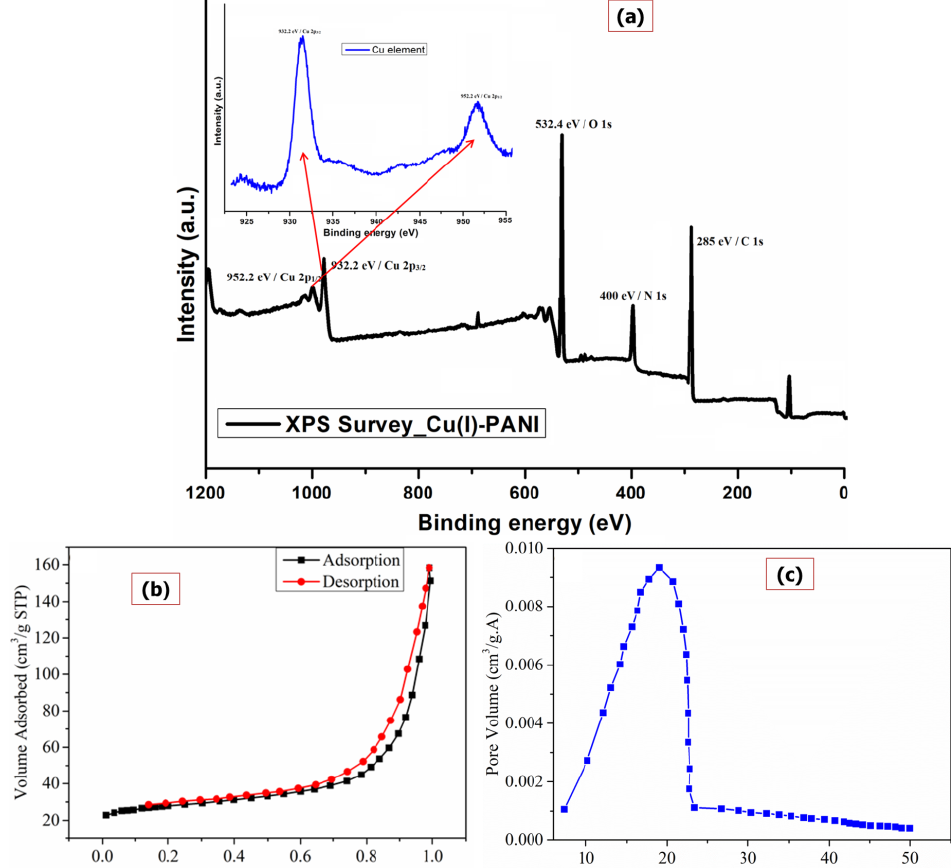
Figure 3 . ( a ) XPS analysis, ( b ) BET surface area, and ( c ) pore size distribution curve of Cu(I)-PANI composite.